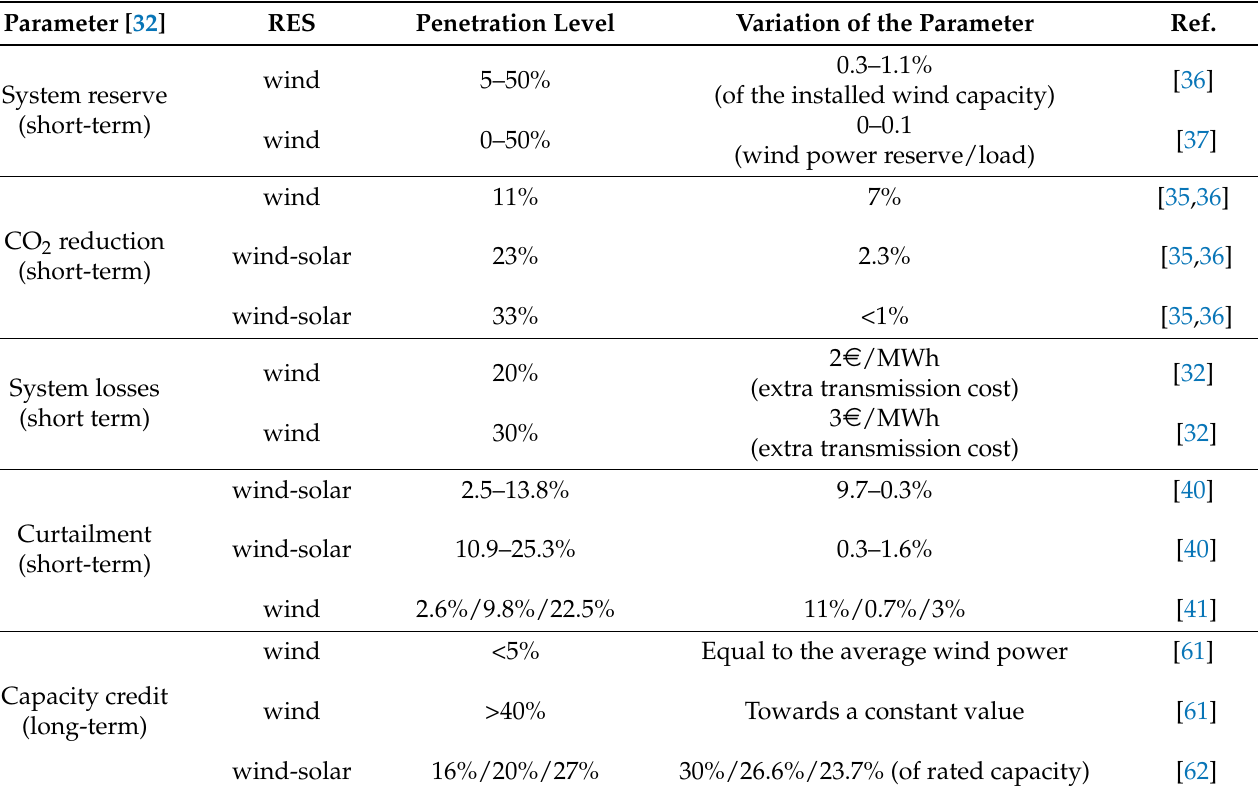
Table 1. Summary of the quantitative impacts of RES on the power